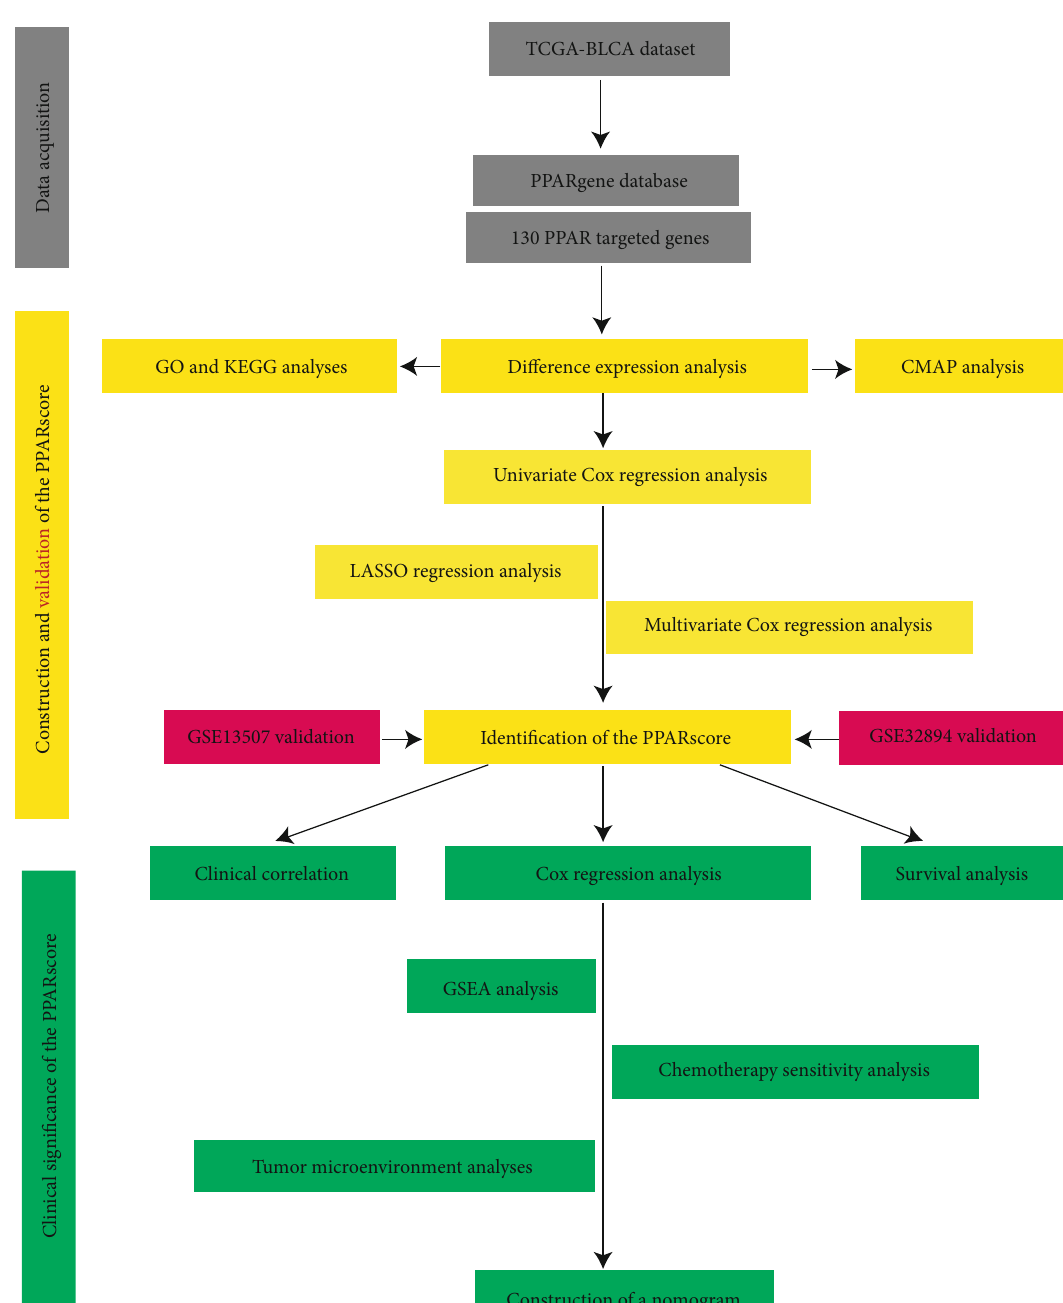
Figure 1: The fl ow chart of the PPAR signature in predicting survival of